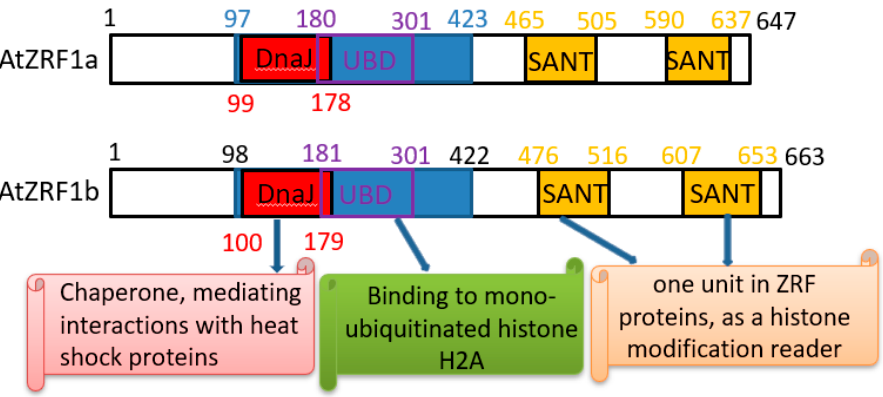
Figure 1. Schematic diagram of Arabidopsis ZRF1a/b for conserved functional domain organization.